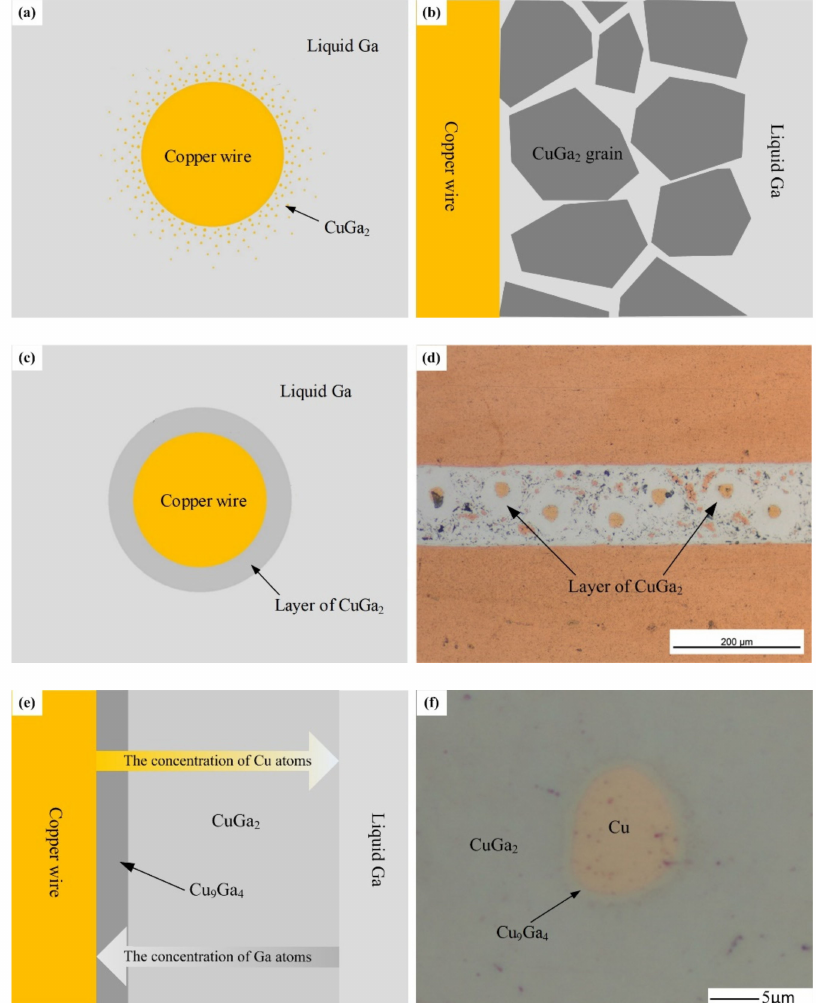
Figure 10. Schematic of the mechanism of Cu / Ga SLID bonding. ( a – c ) Formation process of intermetallic compound θ -CuGa 2 ; ( d ) Formation of θ -CuGa 2 layer; ( e ) Di ff usion of elements in isothermal solidification stage; ( f ) Formation of thin γ 3 -Cu 9 Ga 4